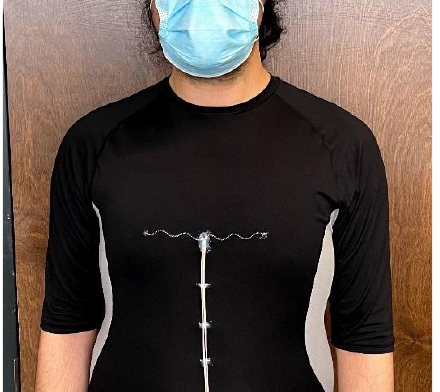
Figure 10. A 50 Ω antenna sensor 𝑛 = 5 , embedded on a smart T-shirt for vital signal monitoring Figure 10. A 50 Ω antenna sensor n = 5, embedded on a smart T-shirt for vital signal monitoring applications.